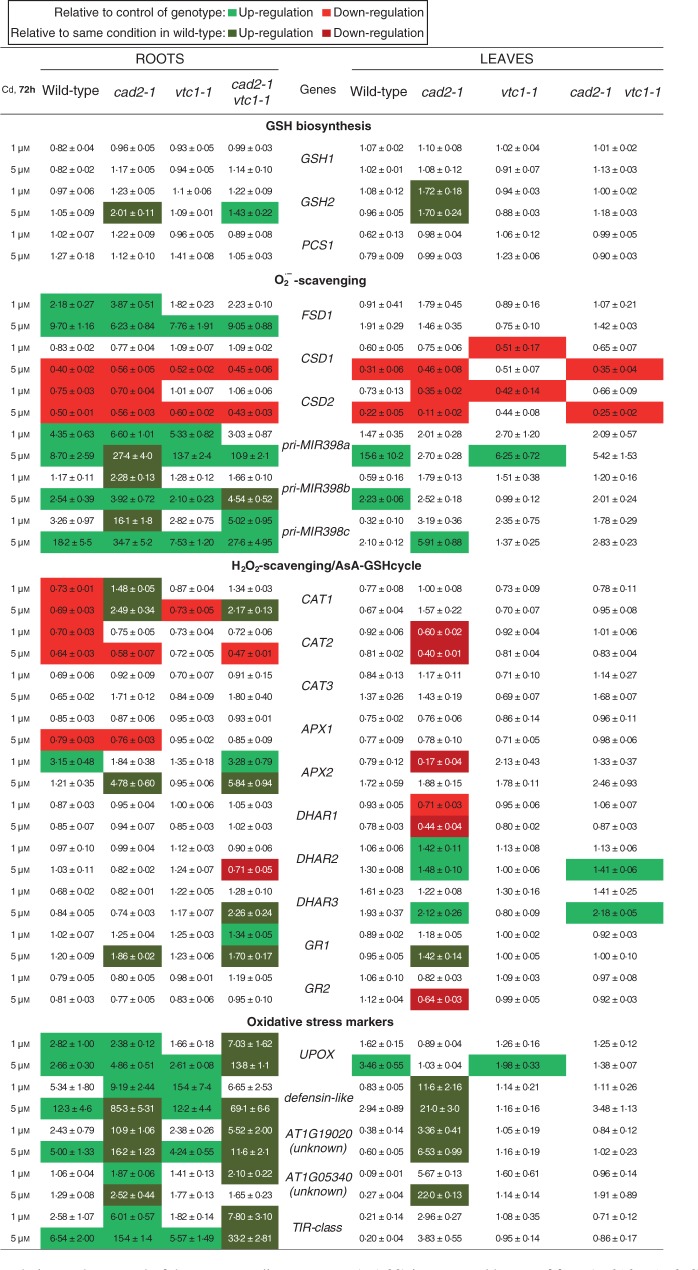
Gene expression patterns relative to the control of the corresponding genotype (=1·00) in roots and leaves of four Arabidopsis thaliana genotypes (wild-type, cad2-1, vtc1-1 and cad2-1 vtc1-1). Plants were exposed to 1 or 5 μm CdSO4 for 72 h in hydroponics. Significant treatment effects relative to the control of the corresponding genotype (light green and light red, see key) and relative to the same condition in wild-type (dark green and dark red; two-way ANOVA; P < 0·05; n = 4). Genes: γ-glutamylcysteine synthetase (GSH1), glutathione synthetase (GSH2), phytochelatin synthase (PCS1), iron superoxide dismutase (FSD1), copper/zinc superoxide dismutase (CSD1-2), primary microRNA398 transcripts (pri-MIR398a-c), catalase (CAT1-3), ascorbate peroxidase (APX1-2), dehydroascorbate reductase (DHAR1-3), glutathione reductase (GR), Toll-Interleukin-1 class (TIR), upregulated by oxidative stress (UPOX).